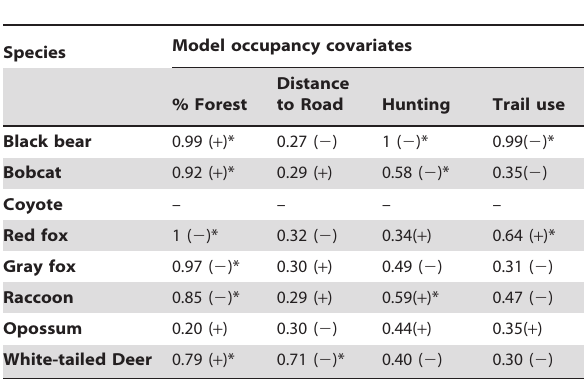
Table 4. The summed model weight and direction of influence for each occupancy covariate in Table